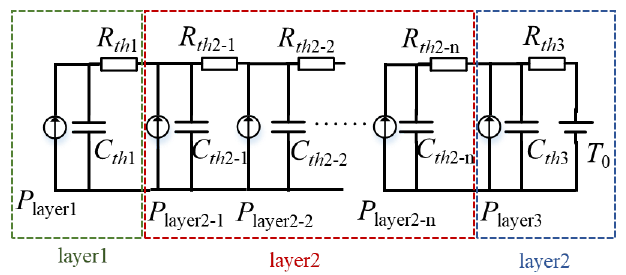
Figure 5. Thermal network model along chip vertical path. The thermal resistance and thermal capacity expression in the thermal network model are shown in Equations (13) and (14), and the heat source expression is shown